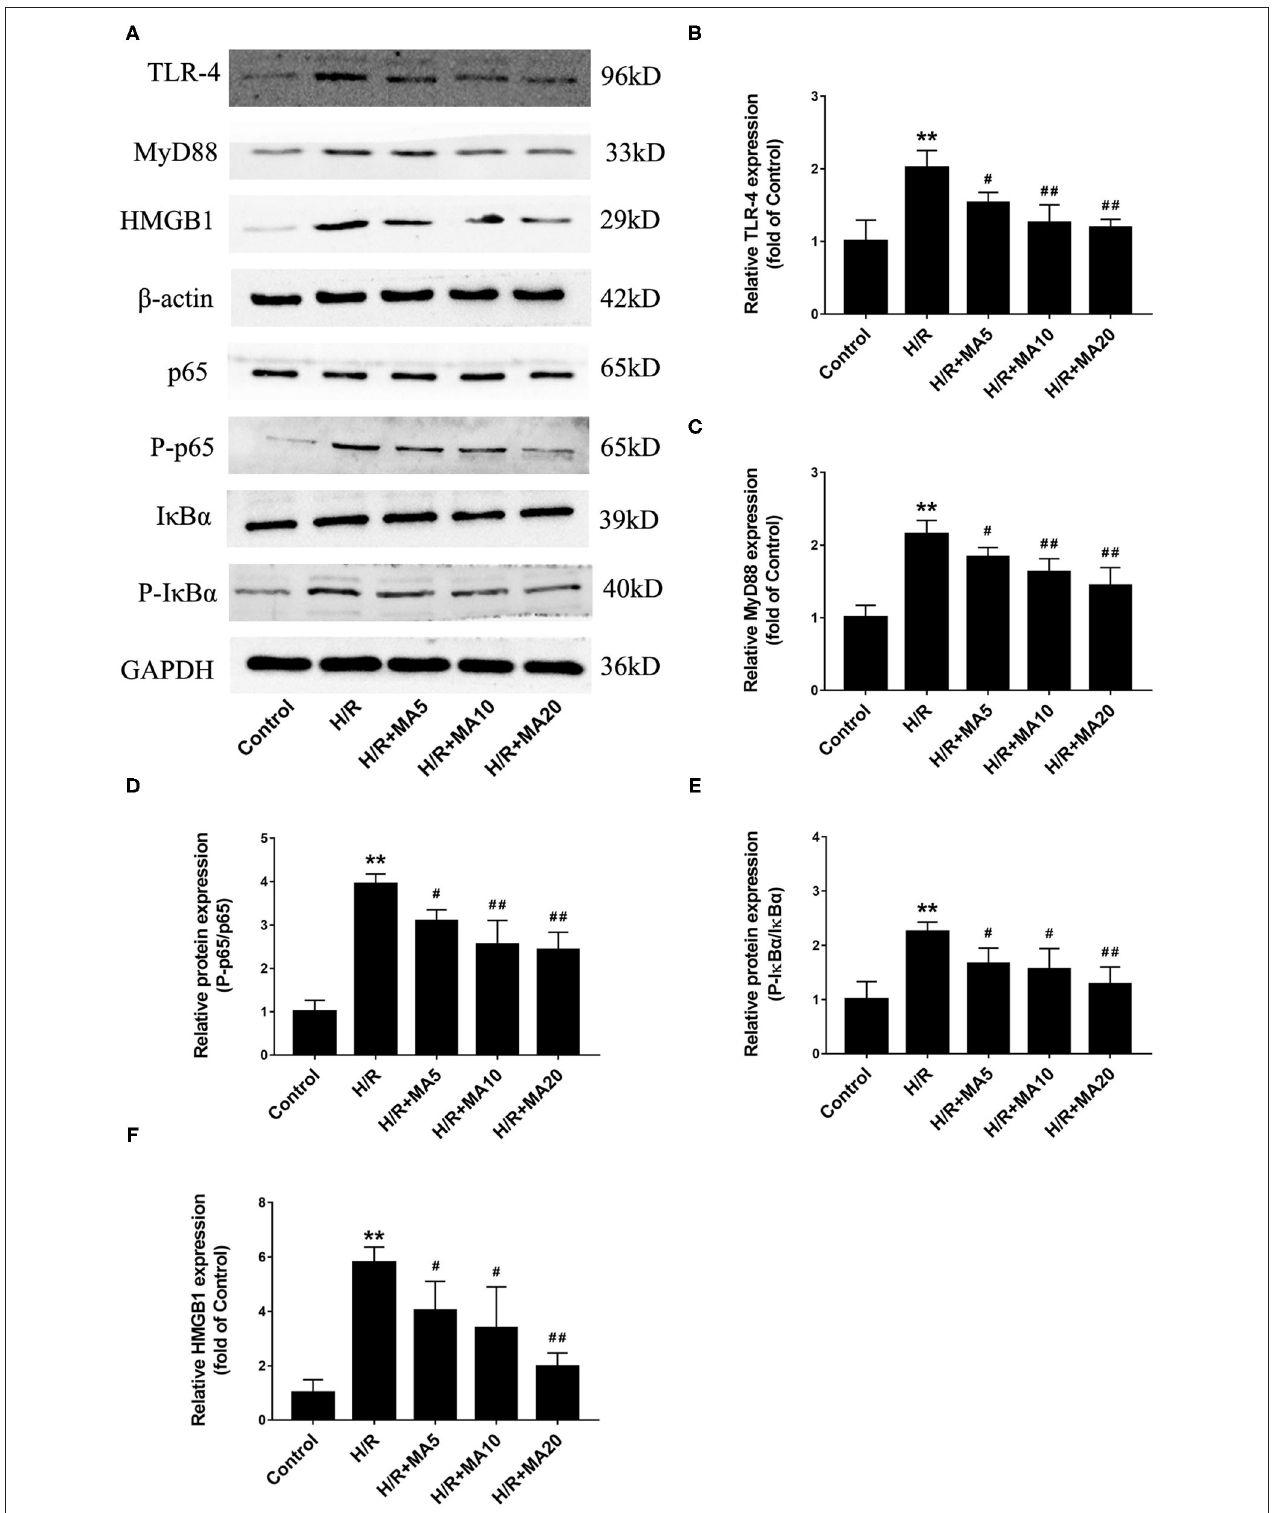
FIGURE 4 | Effect of MA on high mobility group box 1 (HMGB1)- toll-like receptor 4 (TLR4)- myeloid differentiation factor 88 (MyD88)-NF- κ B pathway after H/R treatment. (A) Western blotting was performed to assess the expression of HMGB1, TLR4, MyD88, p65, P-p65, I κ B α , and P-I κ B α in H9c2 cell under H/R conditions. (B–F) The quantitative analyses of HMGB1, TLR4, MyD88, P-p65/p65, and P-I κ B α /I κ B α are shown in bar graphs. All the values are representative of at least three independent experiments and expressed as the mean ± SD. ** P < 0.01 vs. control group; # P < 0.05 and ## P < 0.01 vs. H/R group.